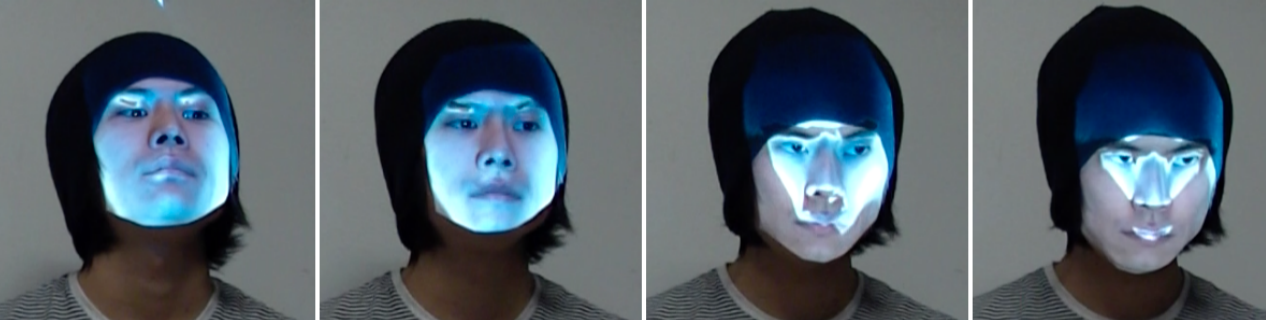
Fig. 7. Metal reflection shading. Similar to the specular reflection example, surface areas whose normals are parallel to the incident direction of light, i.e., similar to the optical axis of the camera that captured the photos above, are highlighted.